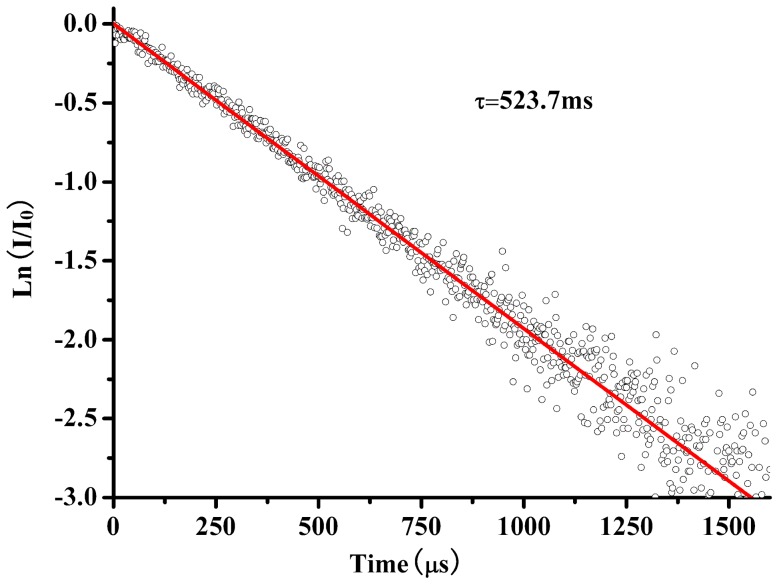
Lifetime decay curve of Yb3+:KBaGd(MoO4)3 crystal at room temperature.